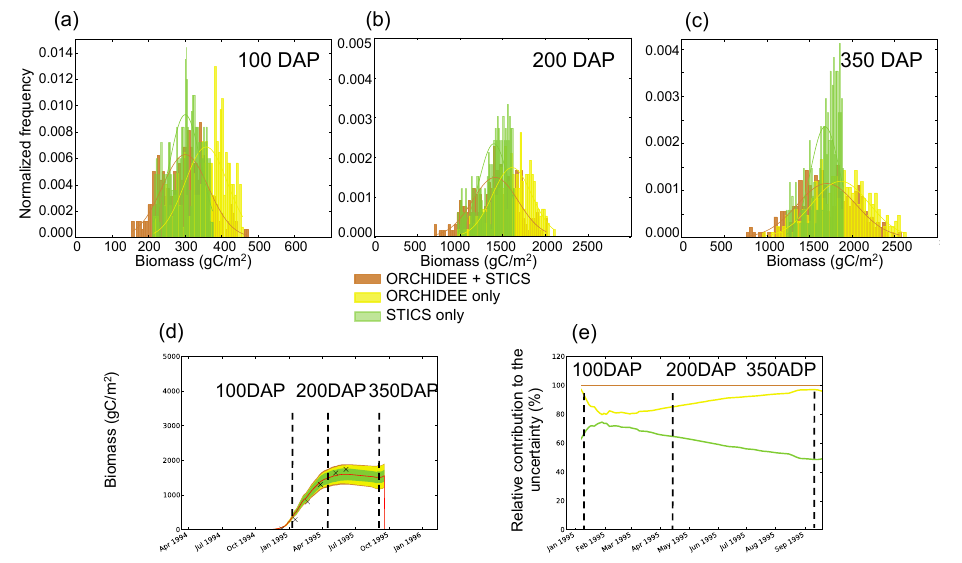
Figure 8. Uncertainty analysis for the site Grafton 94-95 after parameter uncertainty ranges have been constrained through optimization at seven sites. (a–c) Probability distributions of harvested biomass simulated after parameter uncertainty (from STICS: green, from OR- CHIDEE: yellow, from ORCHIDEE + STICS: brown) has been propagated into the model. (d) Reference simulation of harvested biomass (red) and uncertainty from ORCHIDEE, STICS, ORCHIDEE + STICS. (e) Contribution (%) of ORCHIDEE (yellow) and STICS (green) to the total uncertainty (brown) over the length of the growing season.